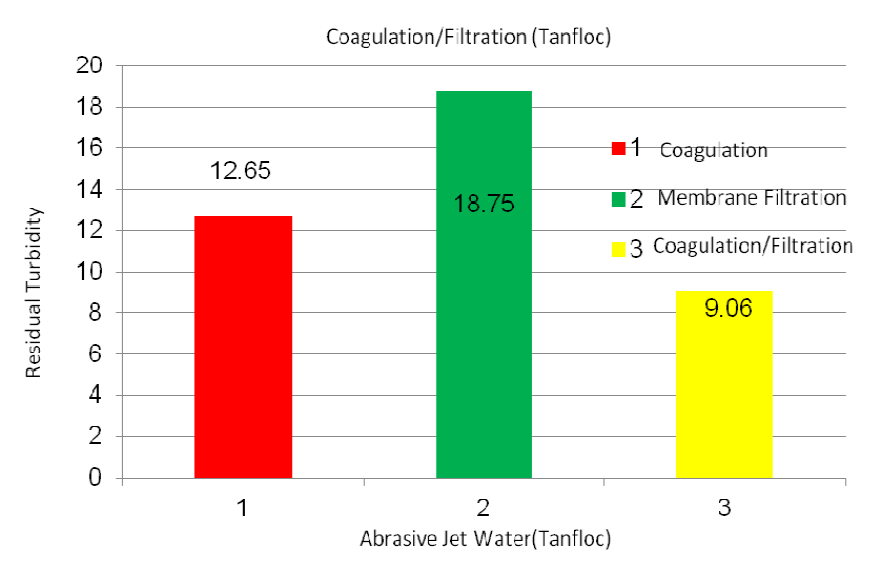
Figure 7. Turbidity values of abrasive jet water using Tanfloc coagulation, membrane filtration, and coagulation + filtration processes; coagulation tests were conducted using 20 mg/L Tanfloc after 1 h of settlement in